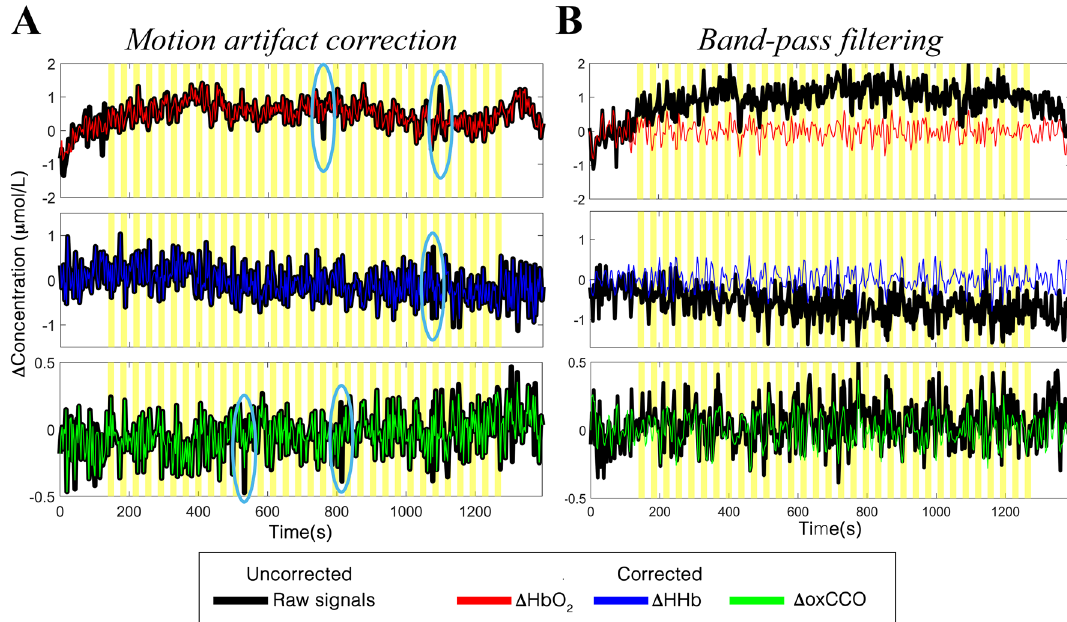
Figure 2. Examples of the result of the application of the preprocessing steps to the ΔHbO 2 (top), ΔHHb (middle), and ΔoxCCO (bottom) signals of one participant. Panel ( A ) shows the application of motion artifact correction method, where examples of artifacts are circled in light blue. Panel ( B ) shows the results of the FIR band-pass filtering. Raw uncorrected ΔHbO 2 /ΔHHb,/ΔoxCCO are shown in black,; processed ΔHbO 2 , ΔHHb, and ΔoxCCO are shown in red, blue and green respectively. Yellow areas mark the visual task the top right quadrant exhibit a greater increase in HbO 2 and oxCCO, and a greater decrease in HHb, leading to a high rPWR; e.g. channel 7 has z(HbO 2 ) = 1, z(HHb) = 0.57, z(oxCCO) = 0.84, corresponding to rPWR HbO2 = 1.3 and rCST HbO2 = -− 0.1, and rPWR HHb = 1 and rCST HHb = 0.19, suggesting that during the right hemifield stimula- tion, the primary visual cortex (V1) is characterized by concurrent changes in haemodynamics and metabolism (high rPWR), with nearly null mismatch (low rCST). In our case, almost all the channels are located in the top right and bottom left quadrants, suggesting that functional brain activity of the visual cortex to our task is associ- ated to consistent changes in haemodynamics and metabolism as expected in a healthy population (i.e., greater increase in HbO 2 and oxCCO, and greater decrease in HHb in the areas responding to the experimental task; greater decrease in HbO 2 and oxCCO and greater increase in HHb in the unstimulated areas). In order to localize the patterns of significant rPWR and rCST within the occipital cortex, we carried out channel-wise one sample t -tests against 0 on rPWR HbO2 , rPWR HHb , rCST HbO2 , rCST HHb . Group-level results for rPWR are shown in Fig. 5. t -values maps for rPWR HbO2 and rPWR HHb of each experimental condition (Right/ Left) are presented, where magenta circles indicate the statistically significant channels (p < 0.05) that survived the FDR correction. We did not find any significant result for rCST, except for channel 10 covering the right V1-V2 regions (Supplementary Table 1) where we found a significant reduction in the coupling between HHb and oxCCO for the right hemifield stimulation, with changes in HHb exceeding the changes in oxCCO in respect to the rest of the channels. Group-level t -values for both rPWR and rCST are included in Supplementary Tables 3 and 4 respectively.